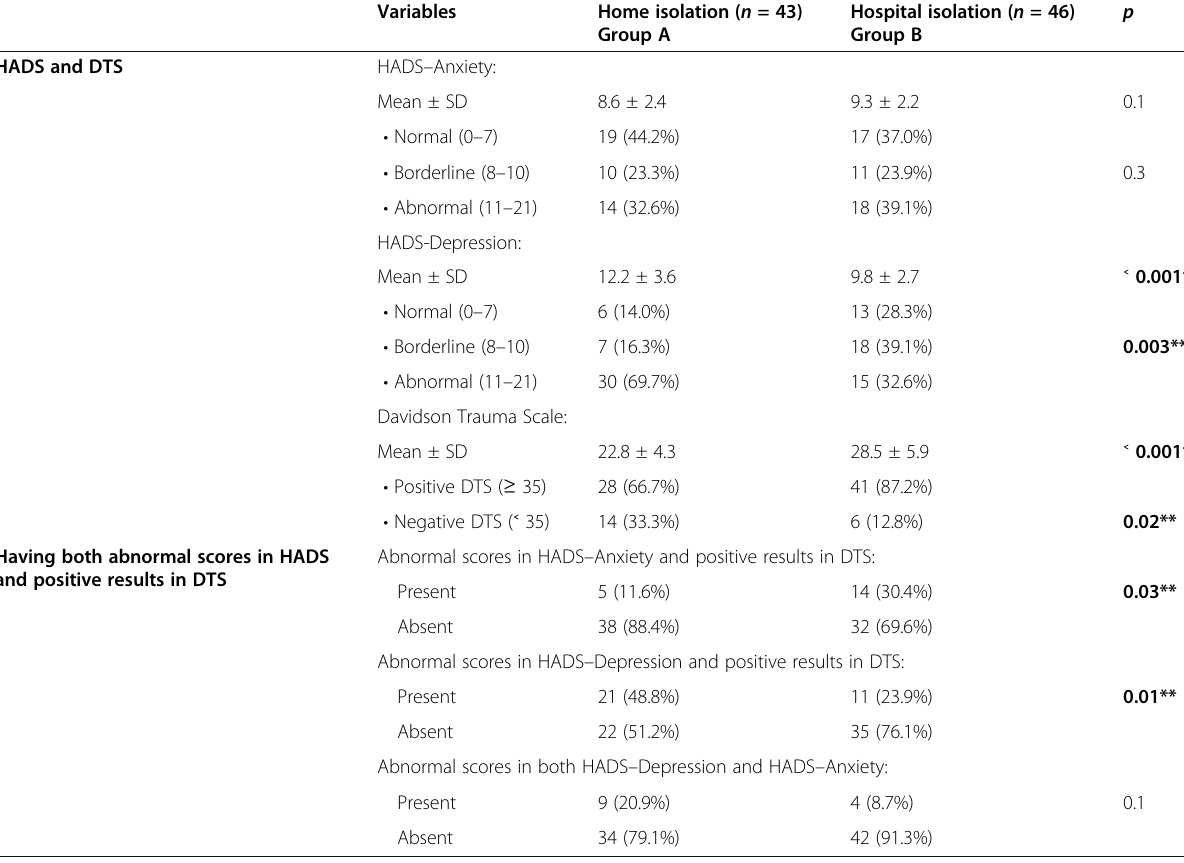
Table 2 Comparison between home-isolated patients and hospital-isolated patients in HADS and DTS and dual diagnosis